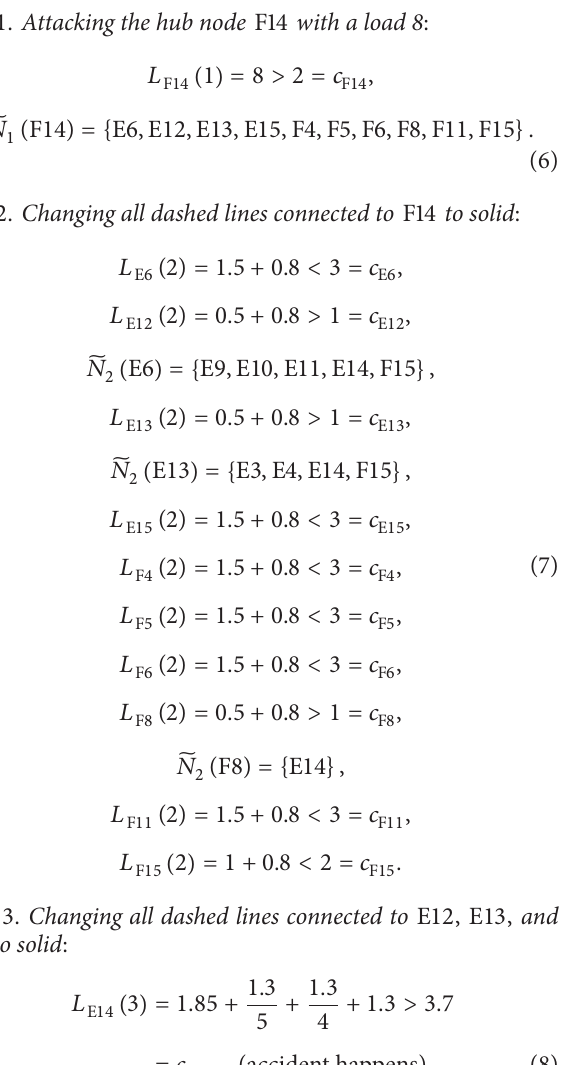
Figure 4: Illustration for the evolution of an accident causation